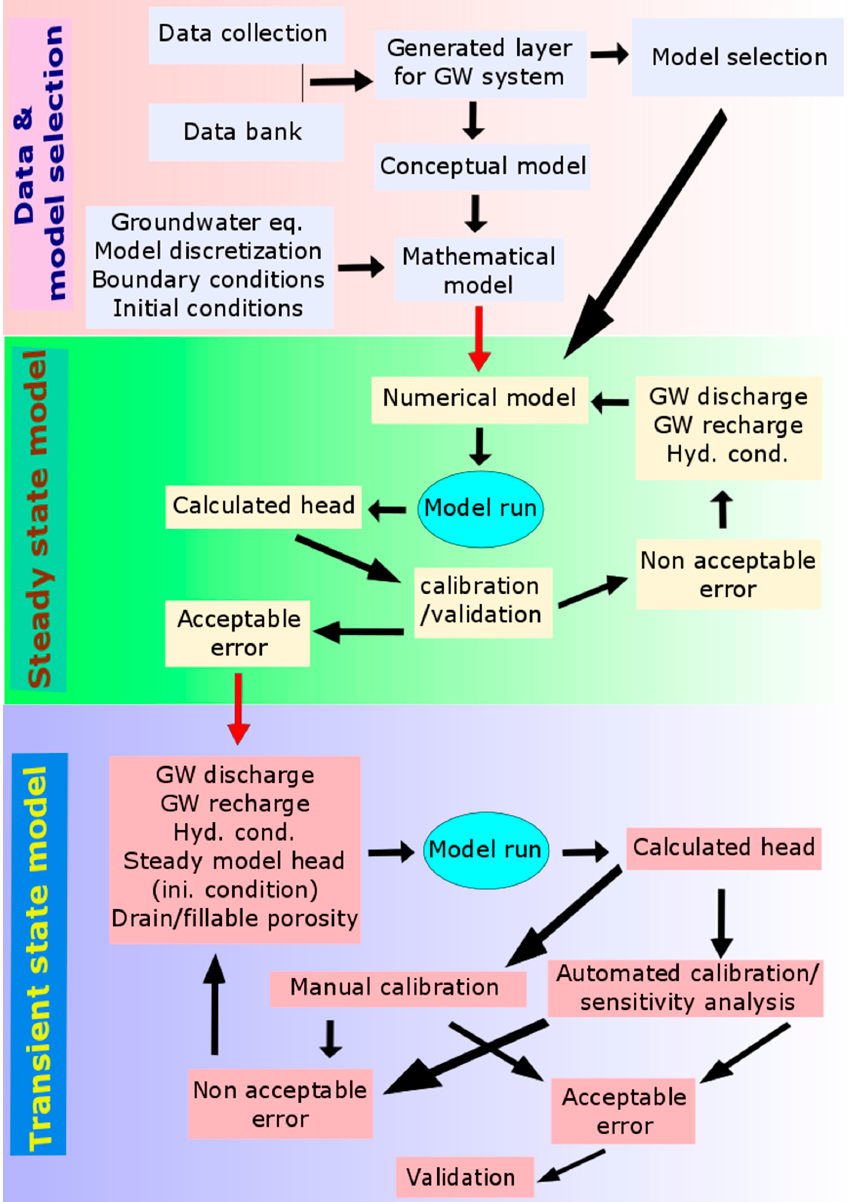
Figure 4. Flow diagram of the adopted methodology.